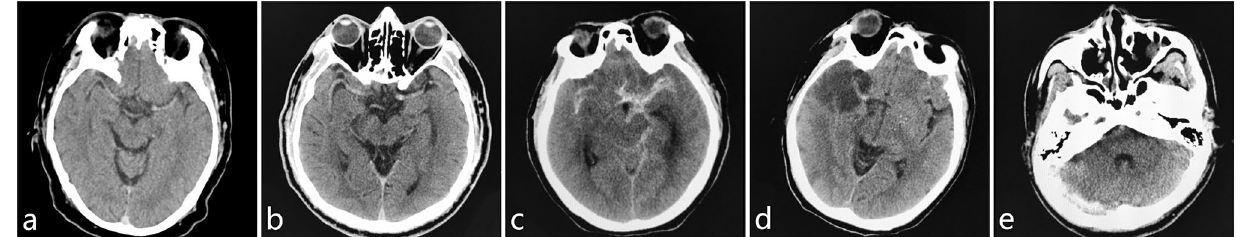
Figure 3. The participants in the plateau group had a higher density of cerebral vessels ( a ). The high brain blood vessel density was still apparent due to the residual contrast agent ( b ). Subarachnoid haemorrhage ( c ). The hyperdense artery sign is the feature of the infarcted blood vessel, while there should be ischemic features at the aerenchyma that the blood vessel irrigates ( d ). Transverse sinus in the right side sinus thrombosis ( e